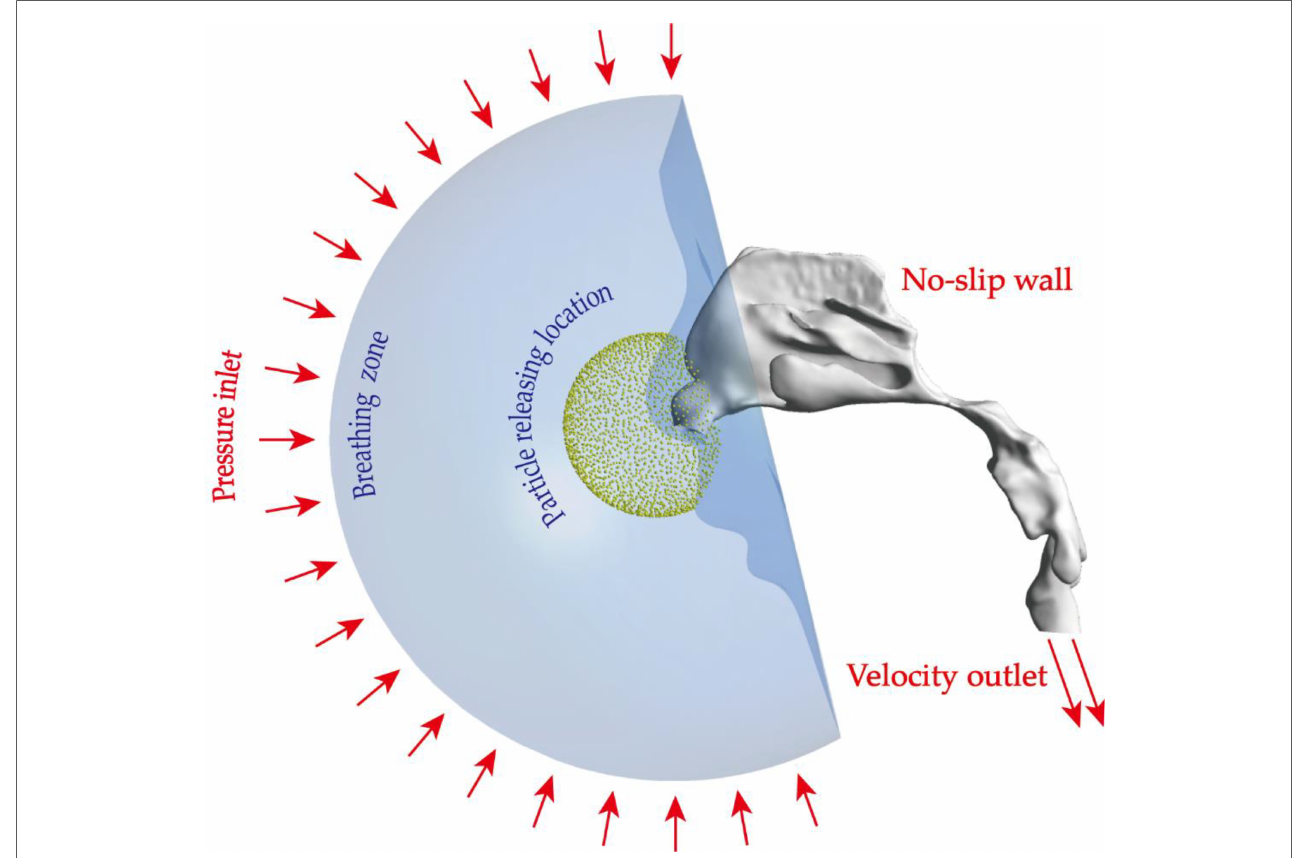
FIGURE 3 Setup of boundary conditions: pressure inlet condition was imposed on the hemispherical surface of the breathing zone, all nasal walls were set as no-slip condition, velocity outlet conditions were used to produce different fl ow fi elds. Micron particles were virtually released from a spherical location in front of the openings of